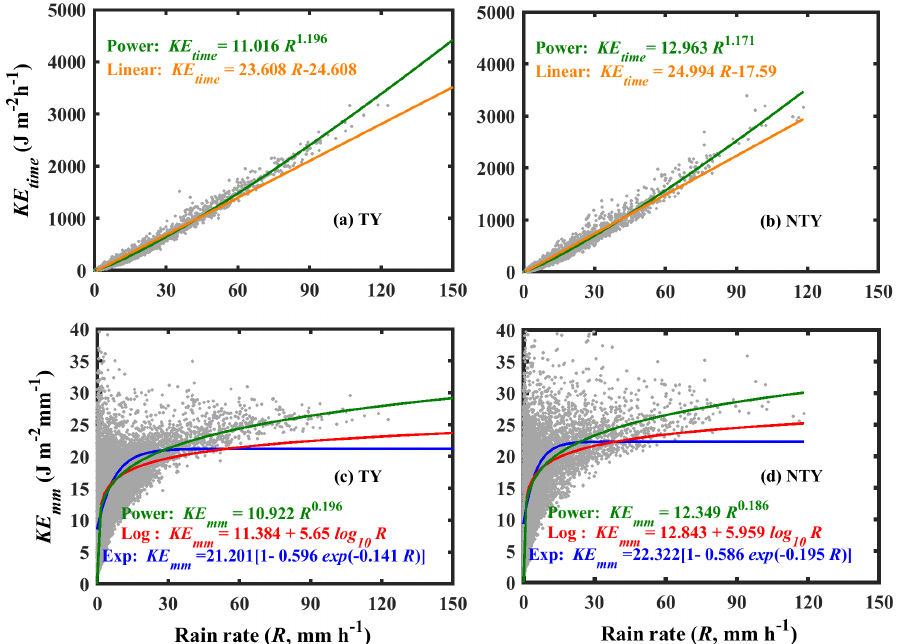
Figure 11. Scatterplots of rainfall kinetic energy (KE; time-specific KE – KE time ; volume-specific KE – KE mm ) with the rainfall rate ( R ; mmh − 1 ) for typhoon (TY) and non-typhoon (NTY)